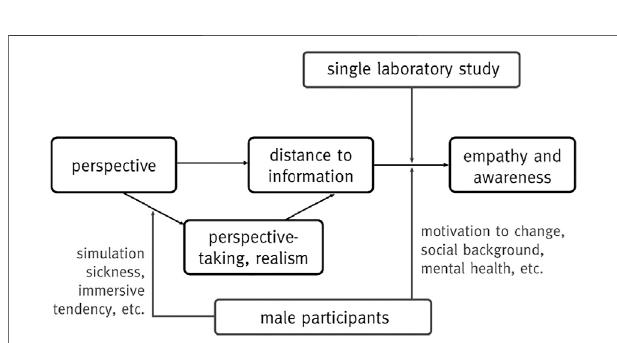
FIGURE 6 | One paradigmatic impact path resulting from use case